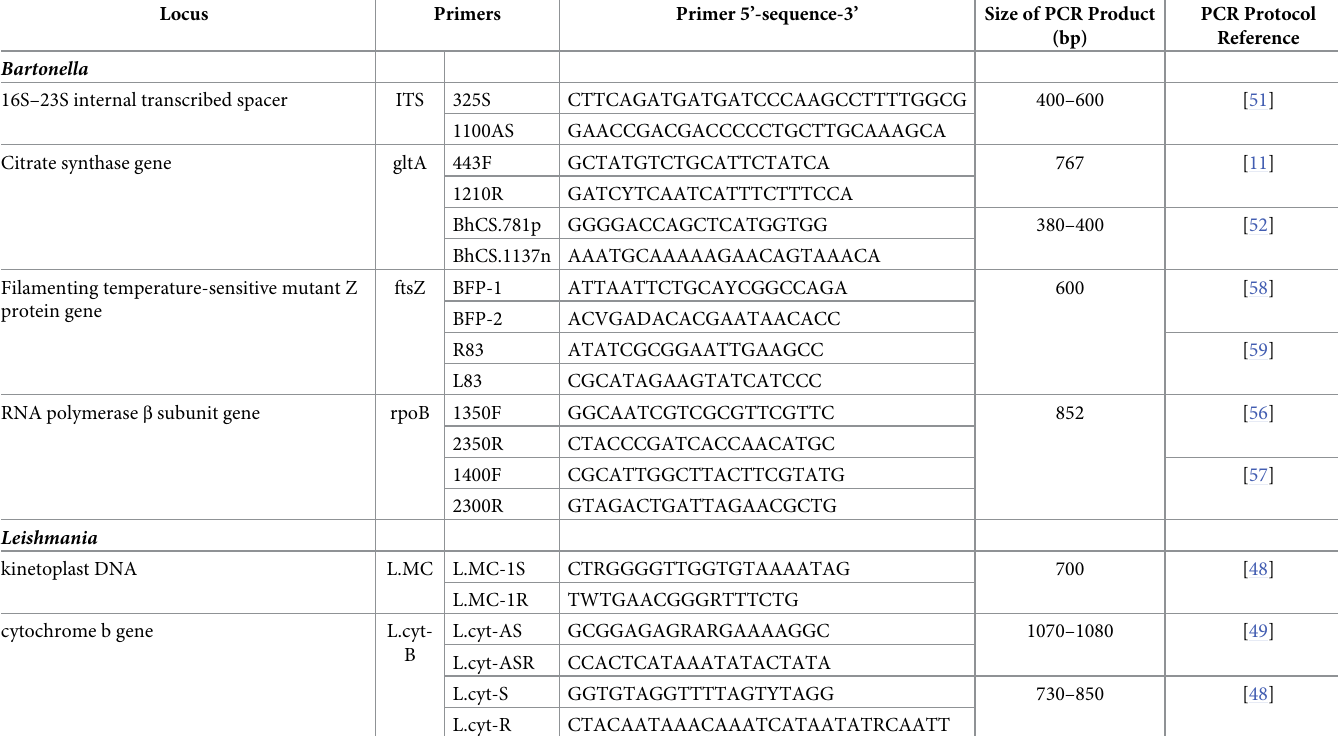
Table 1. Primer sequences for Leishmania and Bartonella DNA amplification from sand flies.